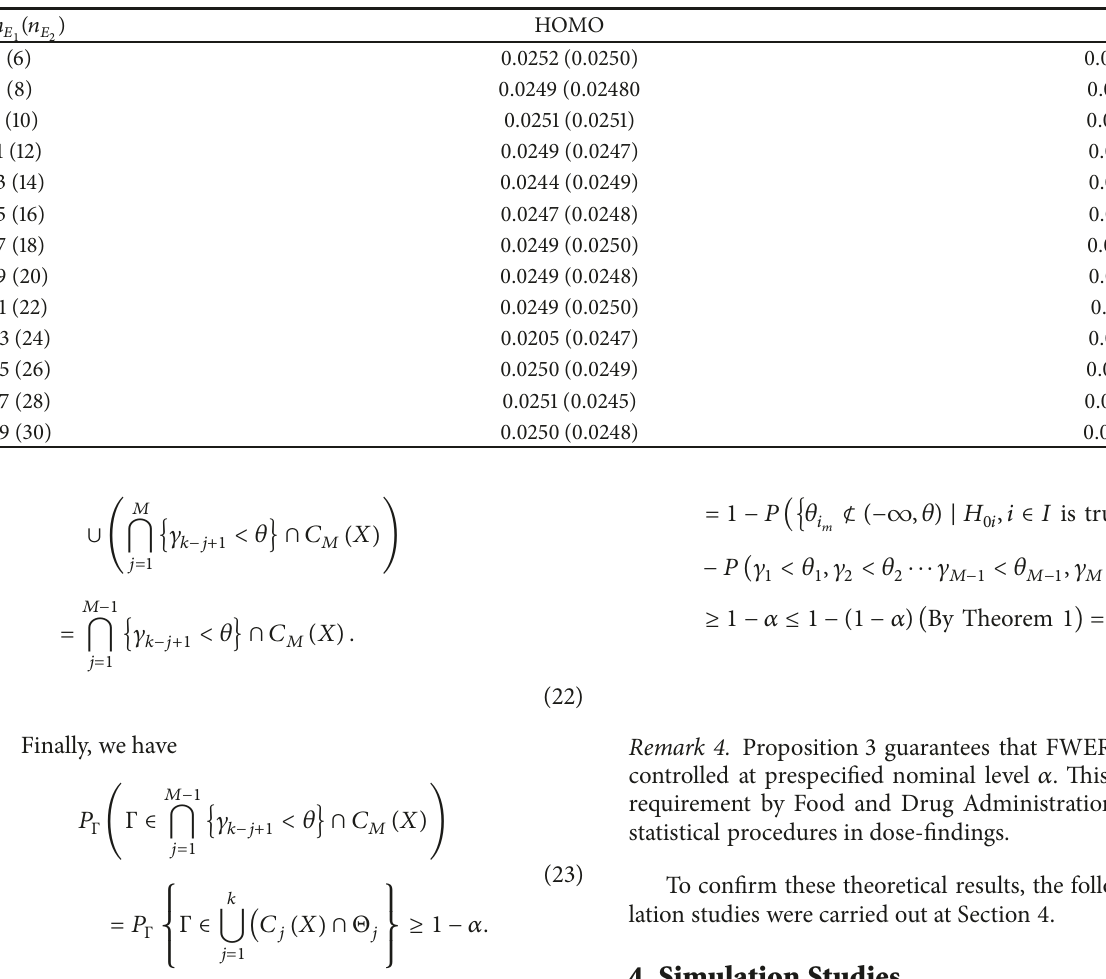
Table 1: Simulated FWER, given 𝛼 = 0.05, 𝑛 𝑅 = 20,𝑛 𝑃 = 20 , and, 𝜃 = 0.8